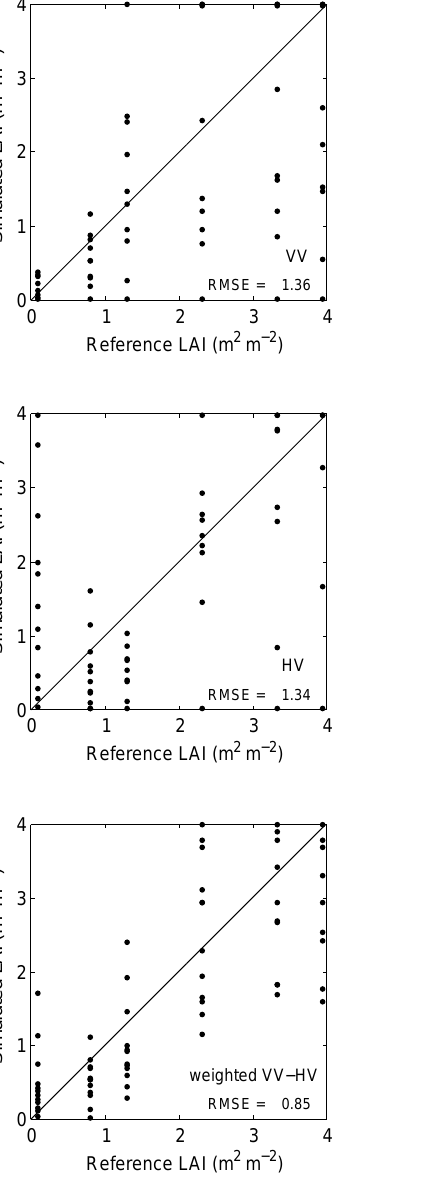
Figure 4. Reference LAI versus simulated LAI, after water cloud model inversion using VV, HH and HV polarizations and after LAI recalculation by weighting VV, HH and HV retrieved LAI ( n =